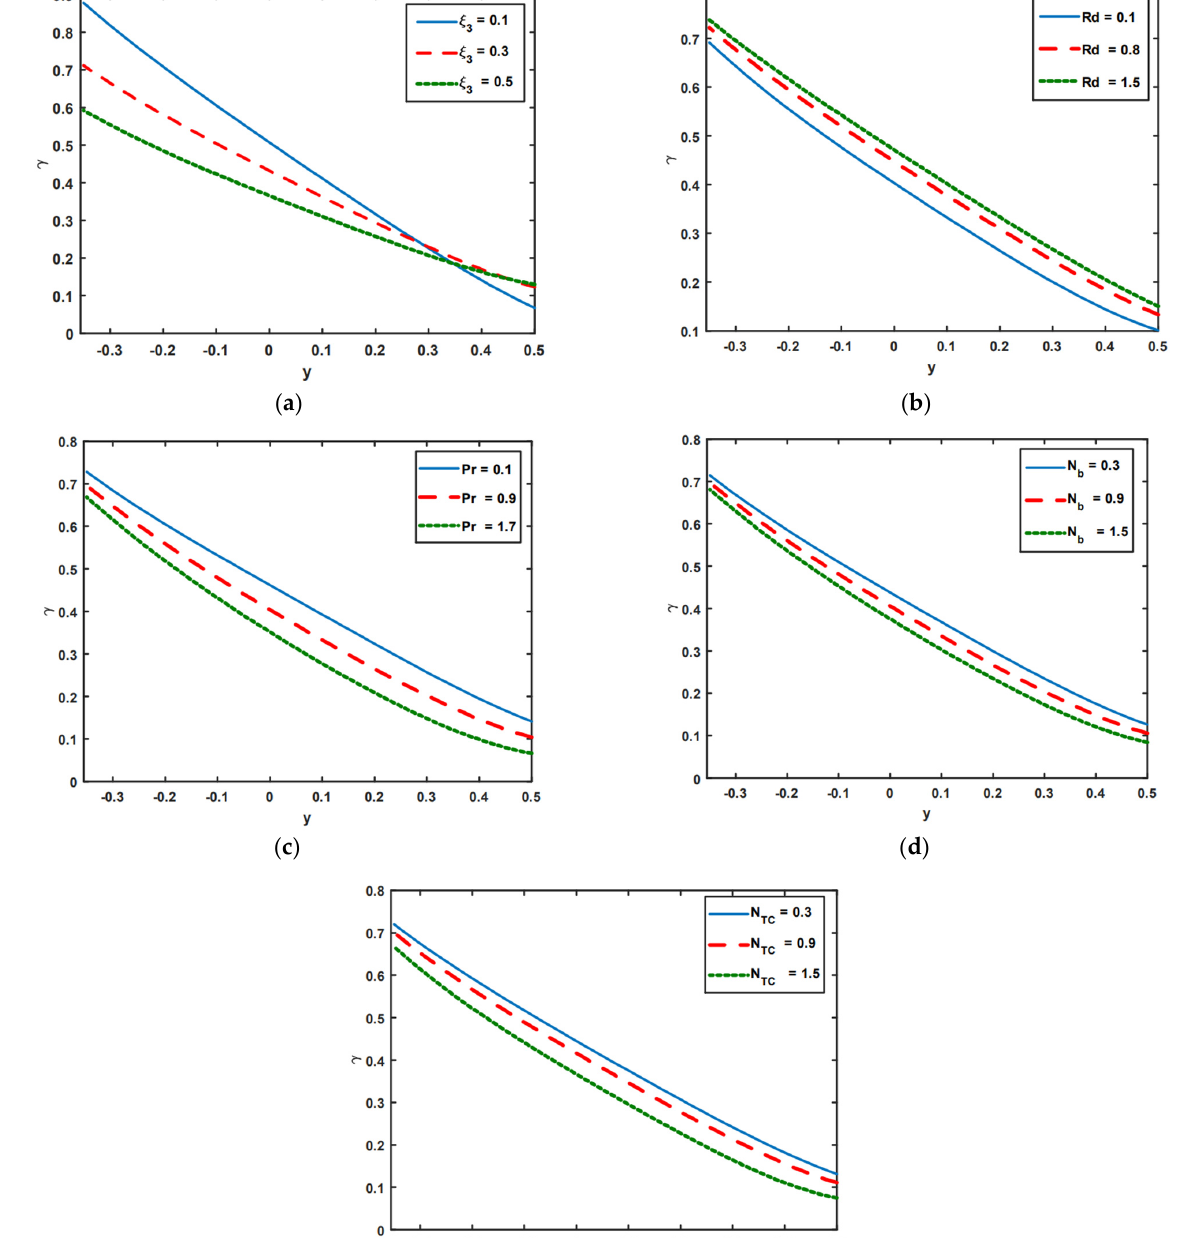
Figure 4. (a–e) Impact of 𝜉 (cid:2870) , 𝐵𝑟, 𝑃𝑟, 𝑁 (cid:3004)(cid:3021) , and 𝑅𝑑 on temperature profile.